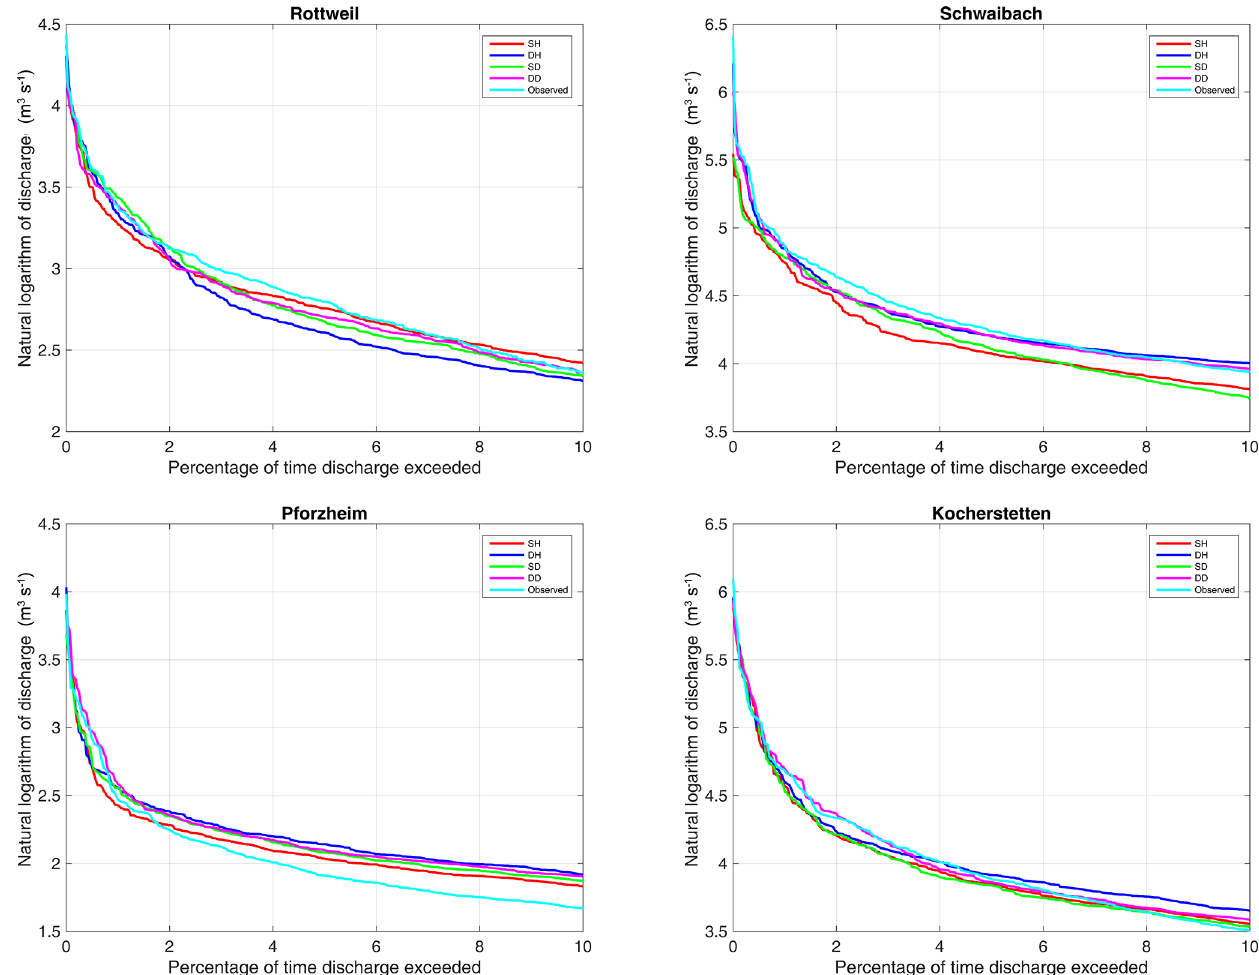
Figure 7. Comparison of the simulated flow duration curve for flows higher than the 10th percentile of flow.